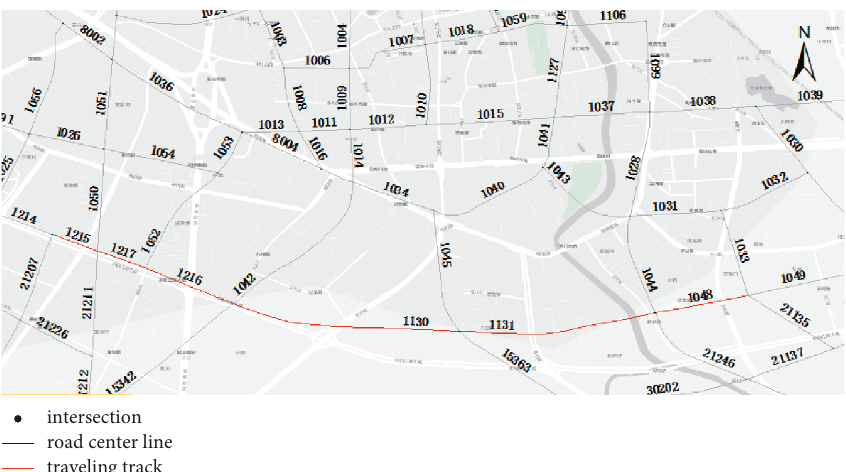
Figure 2: Travel trajectories of single vehicles loaded into the ArcGIS network